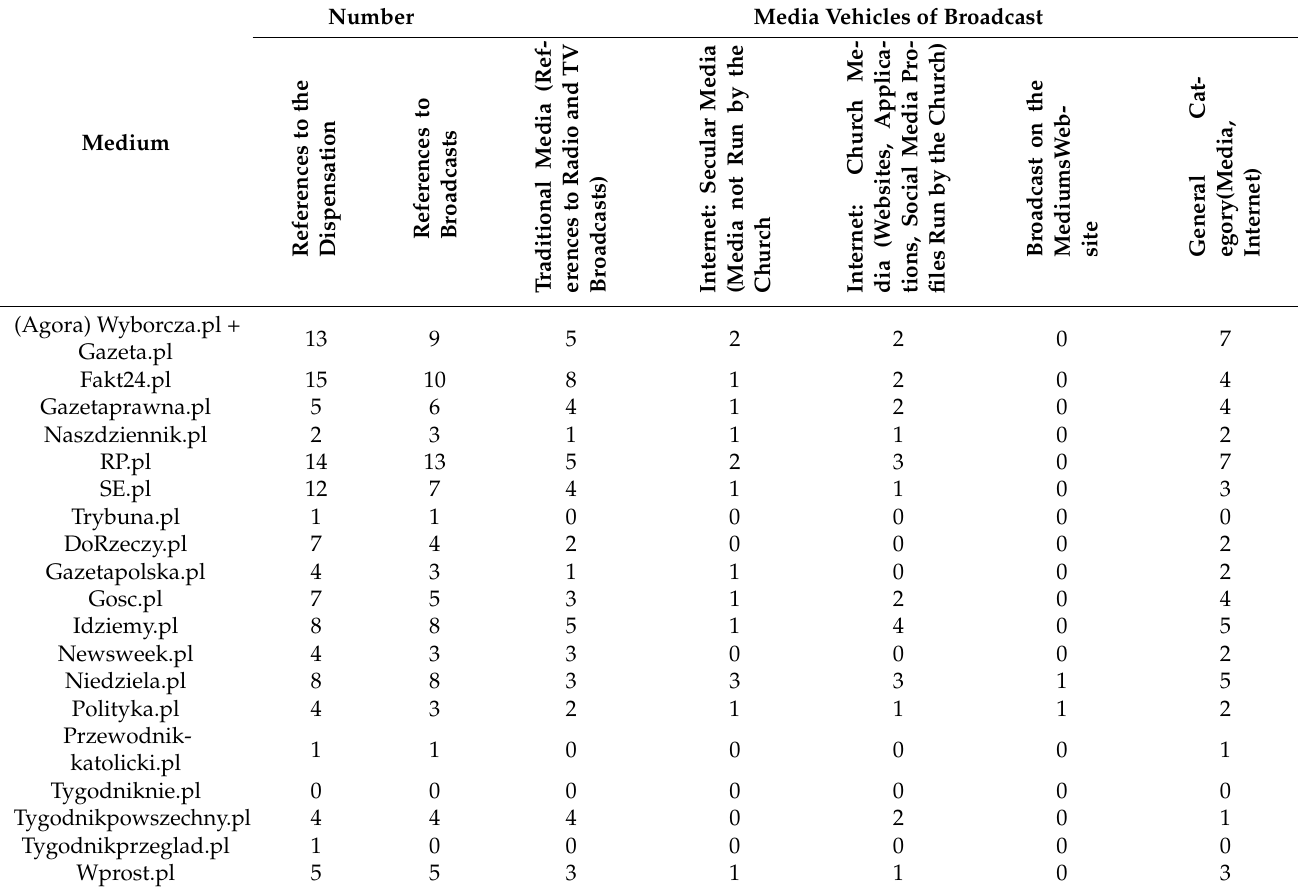
Table 8. References and media vehicles (the numbers do not add up, as one text could have several contexts).